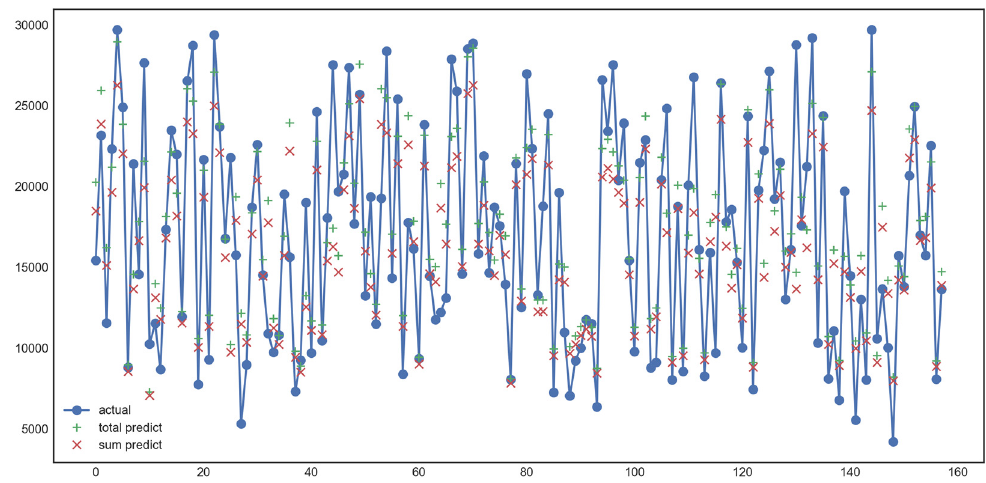
Figure 11. Cost prediction from total cost and cost sum.